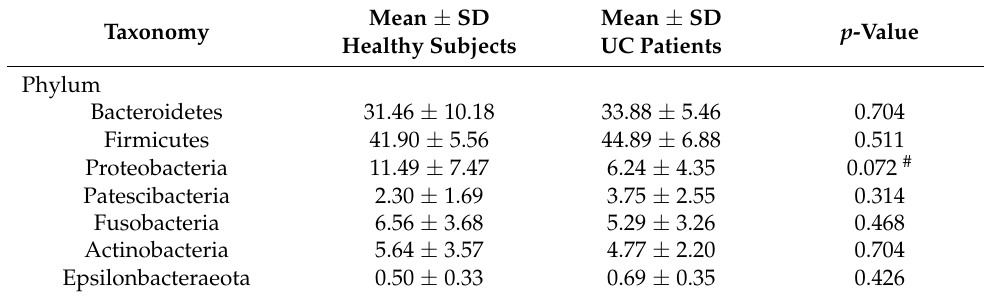
Table 1. Comparison of the oral taxonomic profiles between UC patients and healthy subjects. Only taxa with an average relative abundance > 0.5% are represented.